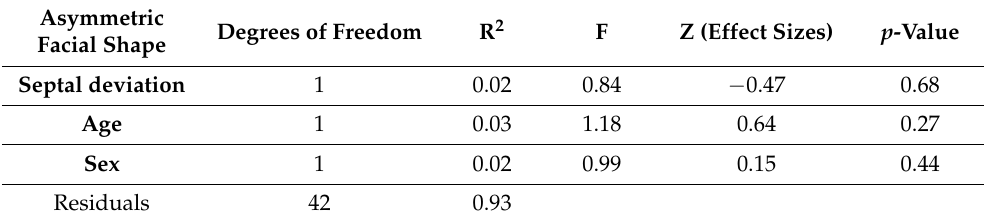
Table 6. Results of the Multivariate Procrustes ANOVA between the dependent variable of asym- metric facial shape and the independent variables of septal deviation (relative values), age, and sex.